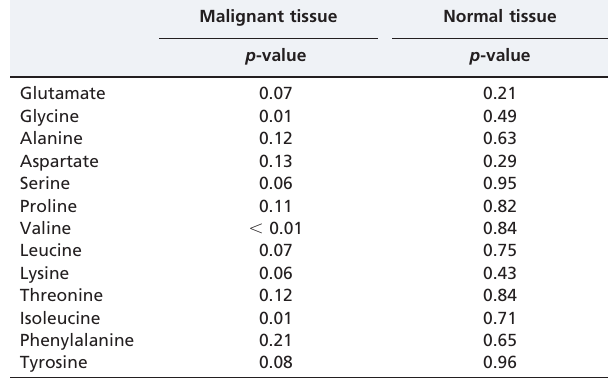
Table 3 - Amino acid comparison between larynx and oral cavity